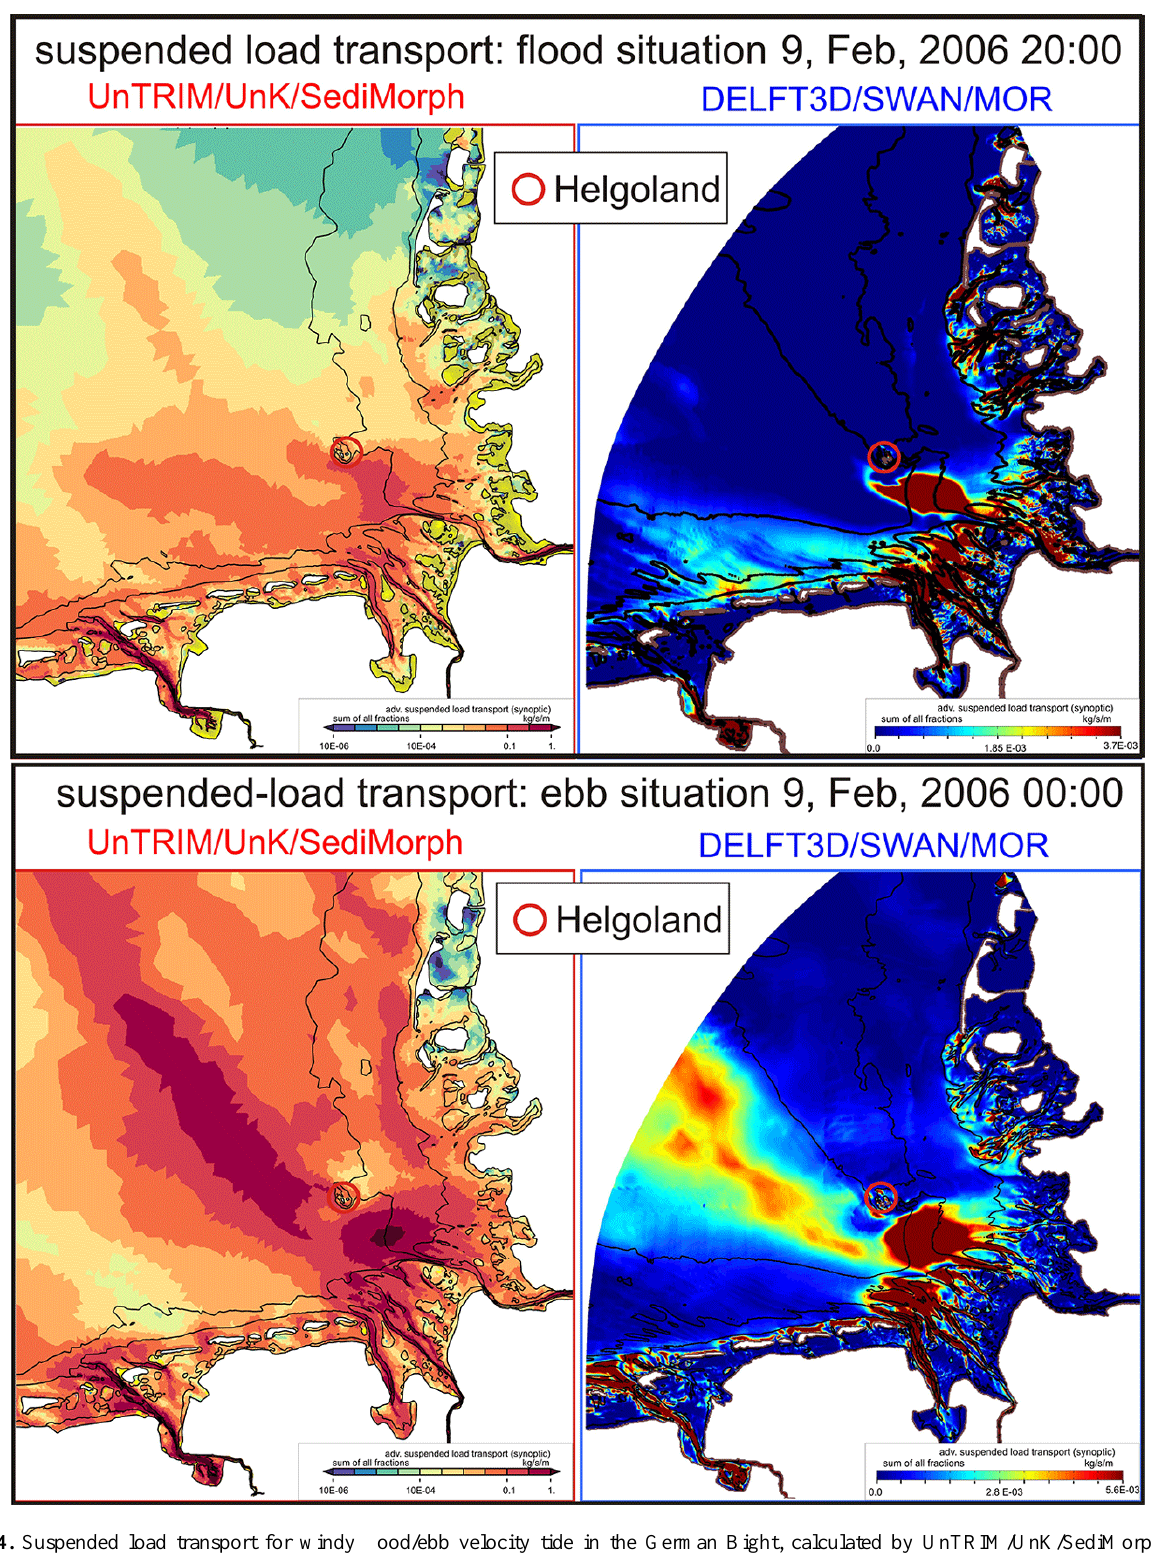
Fig. 4. Suspended load transport for windy flood/ebb velocity tide in the German Bight, calculated by UnTRIM/UnK/SediMorph and DELFT3D(2-D